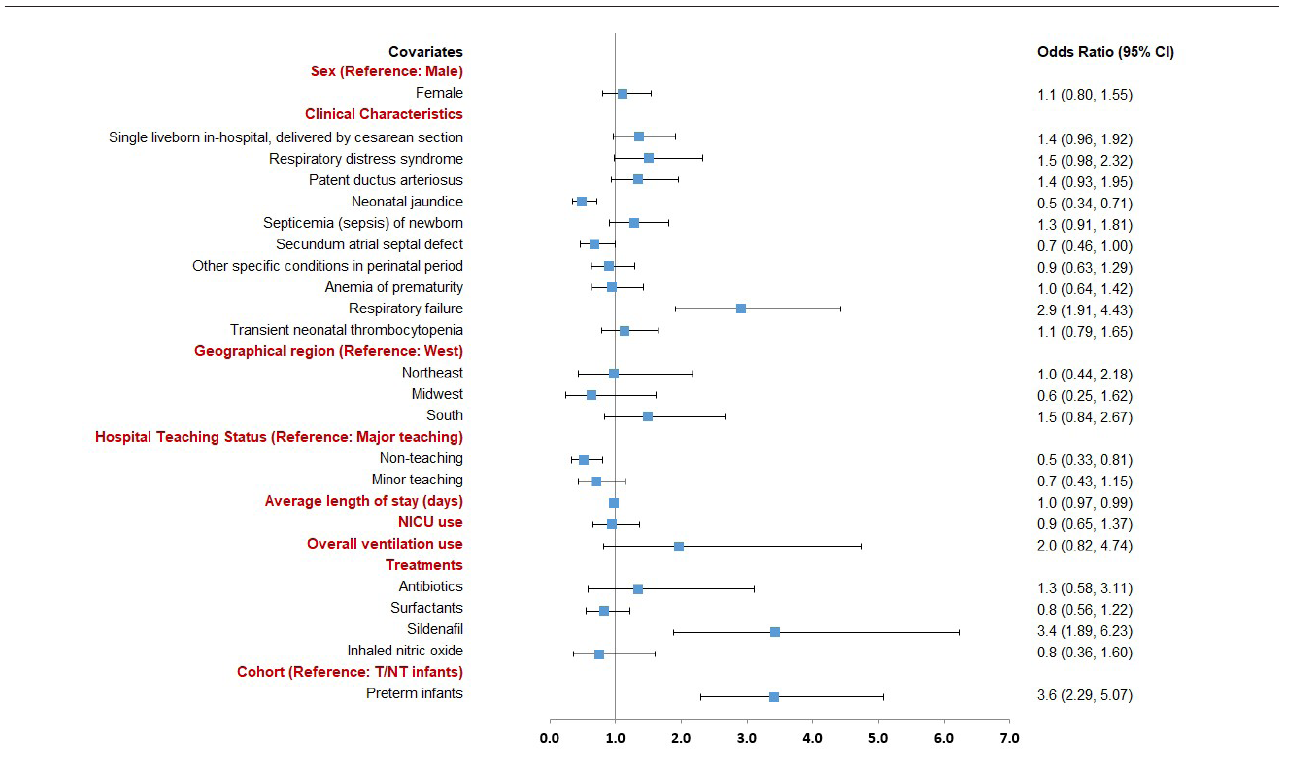
Figure 3. Factors Associated with Mortality Among Preterm and Term/Near-term Infants diagnosed with